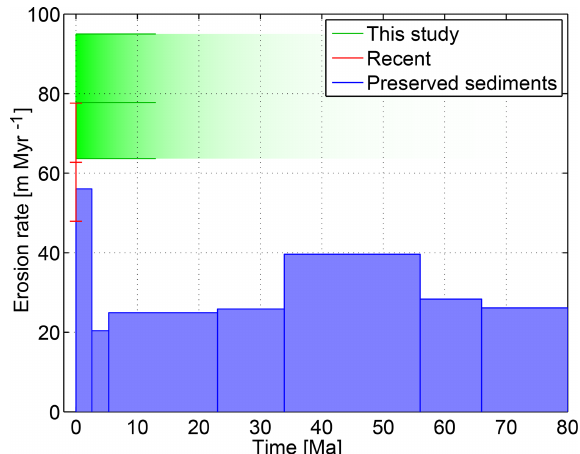
Figure 8. Comparison of our worldwide long-term mean erosion rate with estimates obtained from preserved sediments (Wilkinson and McElroy, 2007) and recent erosion rates compiled by Willen- bring et al. (2013). The green area represents our result for the mean erosion rate of r = 78mMyr − 1 with 70% confidence intervals. The decreasing opacity visualizes the exponentially decreasing sensitiv- ity with τ =